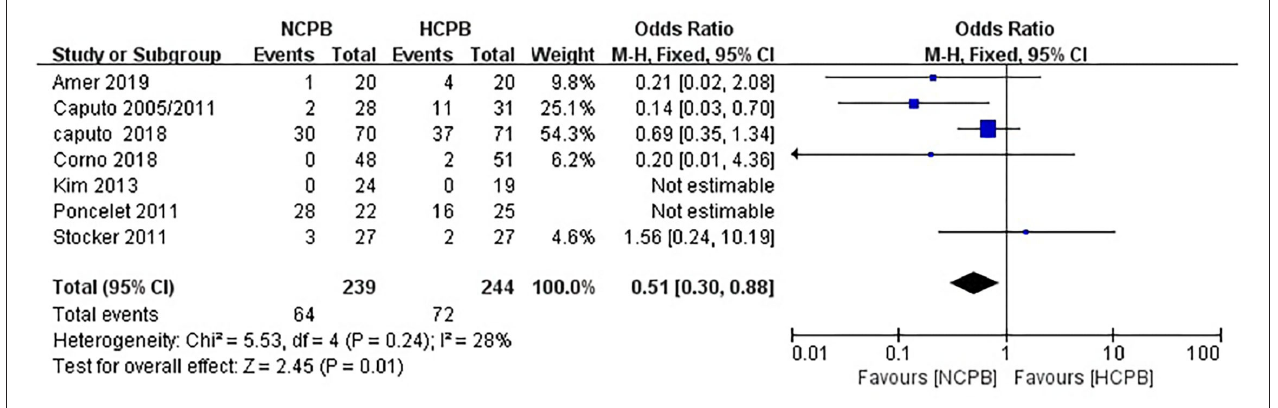
FIGURE 4 | Pooled analysis for major adverse events after simple congenital heart disease